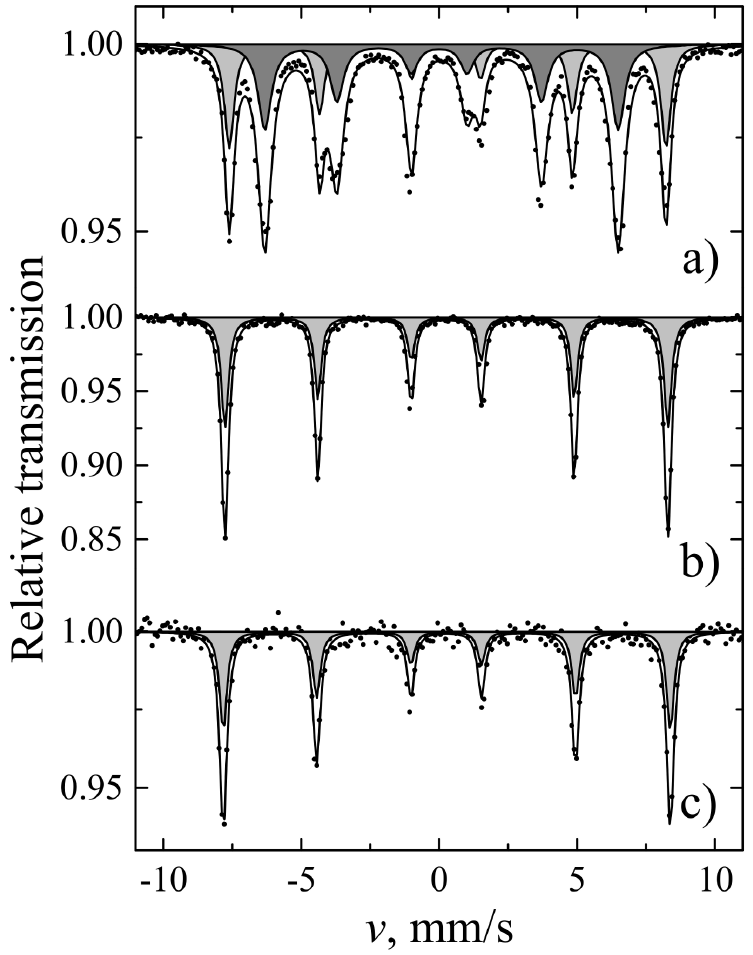
Figure 8. Mössbauer spectra for YIG ( a ), YIP ( b ), and TIP ( c ) bulk samples at room